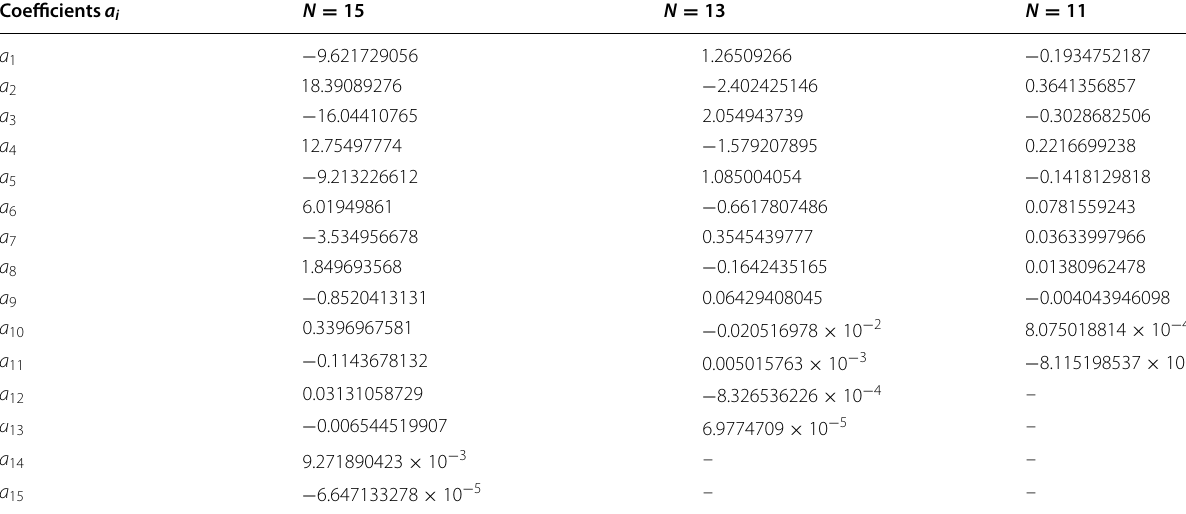
Table 14 Coefficients a i for various N of Rayleigh–Ritz procedures in case